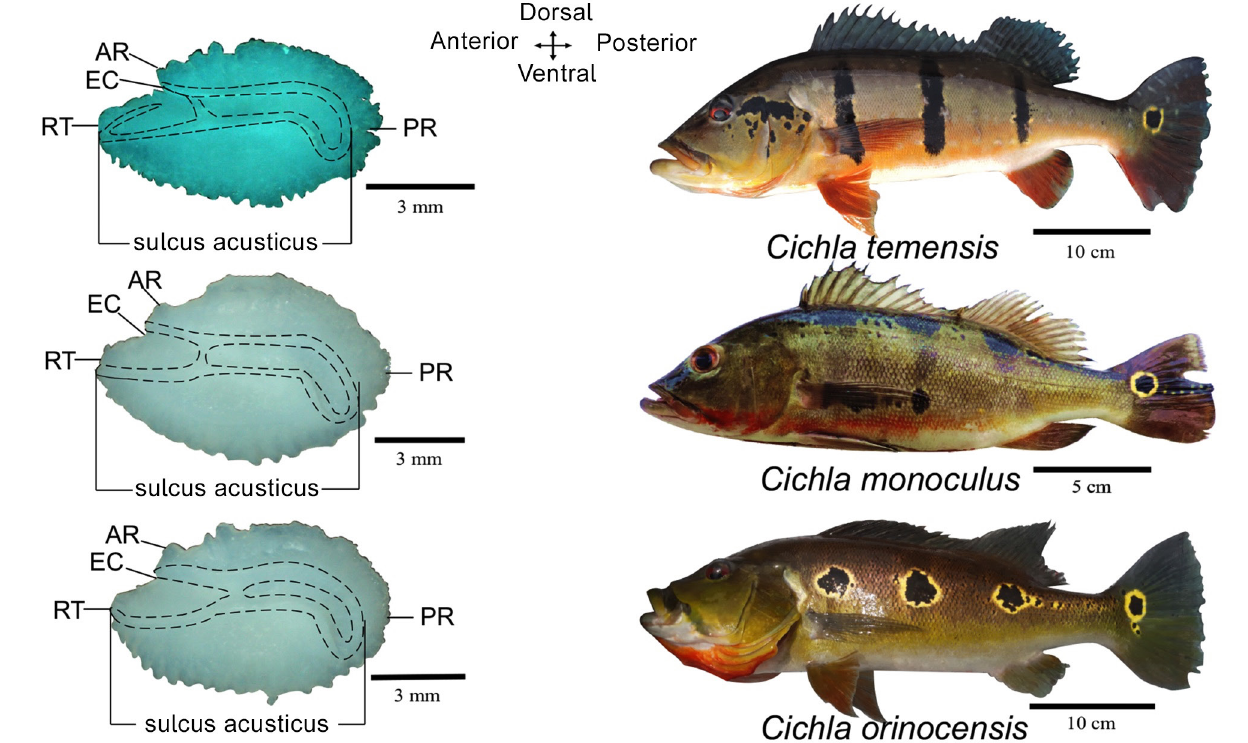
FIGURE 2 | Labelled right-side sagittae otoliths in mesial view of the species Cichla temensis , C. monoculus , and C. orinocensis , according to Gomiero, Braga (2007). RT: rostrum; PR: postrostrum; EC: excisura; AR: